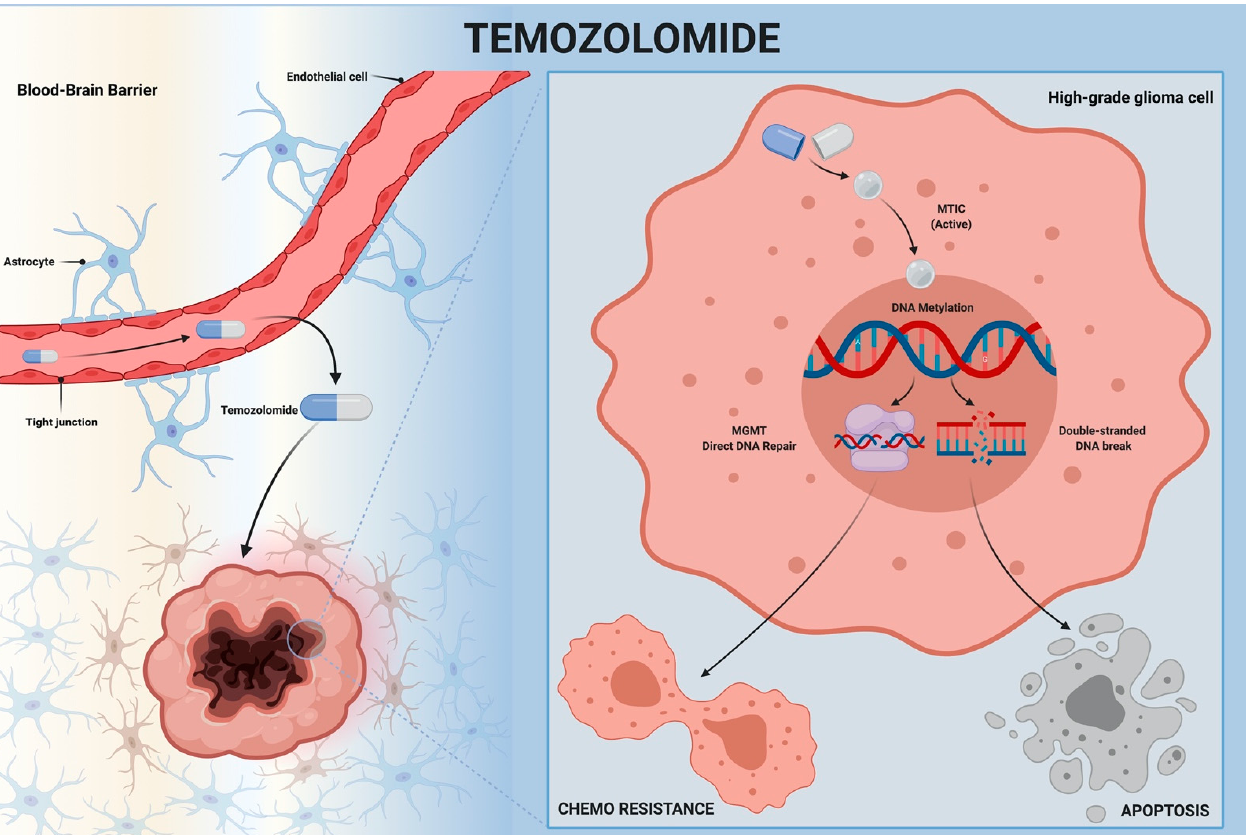
Figure 2. Temozolomide mechanism of action. Temozolomide crosses the blood–brain barrier and reaches high-grade glioma cells. It is spontaneously converted to the active compound (MTIC), which methylates DNA bases, breaks double-strand DNA, and leads to apoptosis. MTIC action is opposed to the DNA repair pathways, including MGMT. MGMT: O6-methylguanine-DNA methyltransferase; MTIC: 5-(3-methyltriazen-1-yl)-imidazole-4-carboxamide; TMZ: Temozolomide.